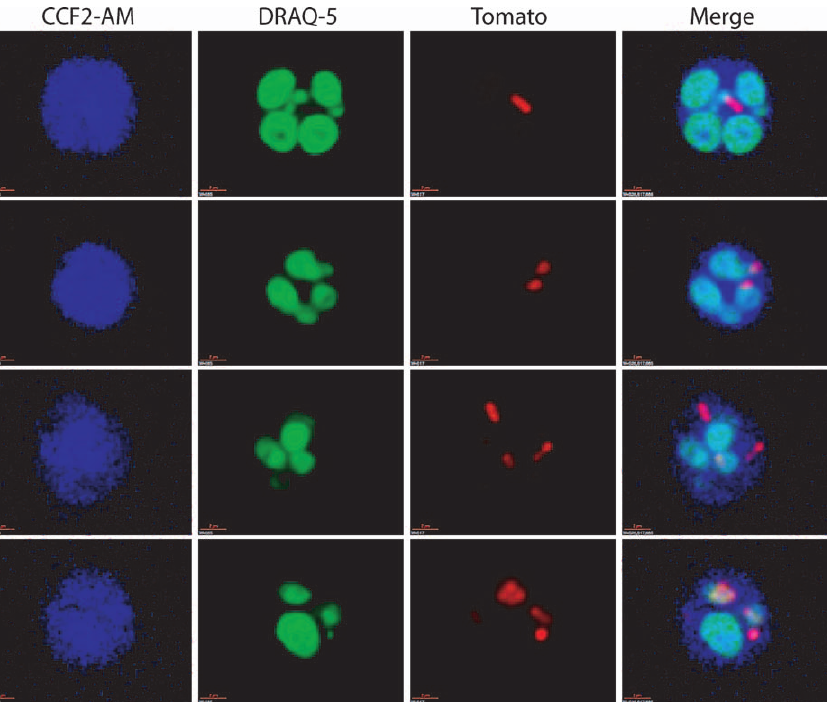
Figure 5. Microscopic Analysis Reveals That FACS Sorted Blue Spleen Cells Contain Intracellular Red-Fluorescent Salmonella Mice were infected as described in Figure 2. Spleen cell suspensions were prepared then loaded with CCF2-AM to detect secretion (shown in blue). FACS sorted secretion positive cells (blue cells) were then stained with a DNA stain, DRAQ5 (shown in green), to visualize nuclei. Images were taken at 60 3 magnification and a single cell is shown in each horizontal row. Red reference bars represent 2 l m.